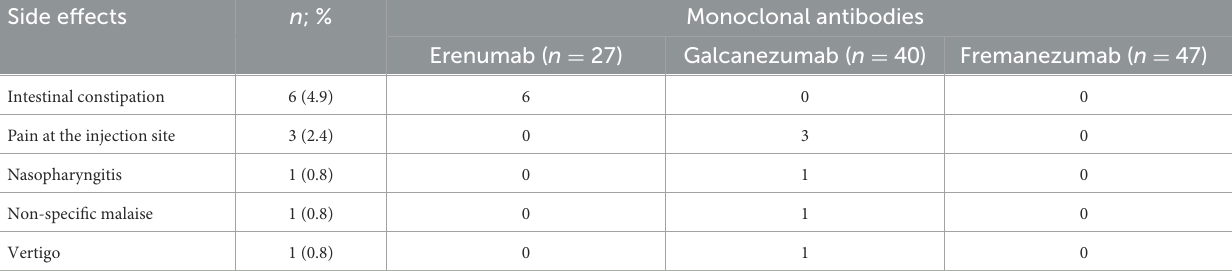
TABLE 5 Adverse effects of mAbs in 114 patients with chronic migraine and medication overuse